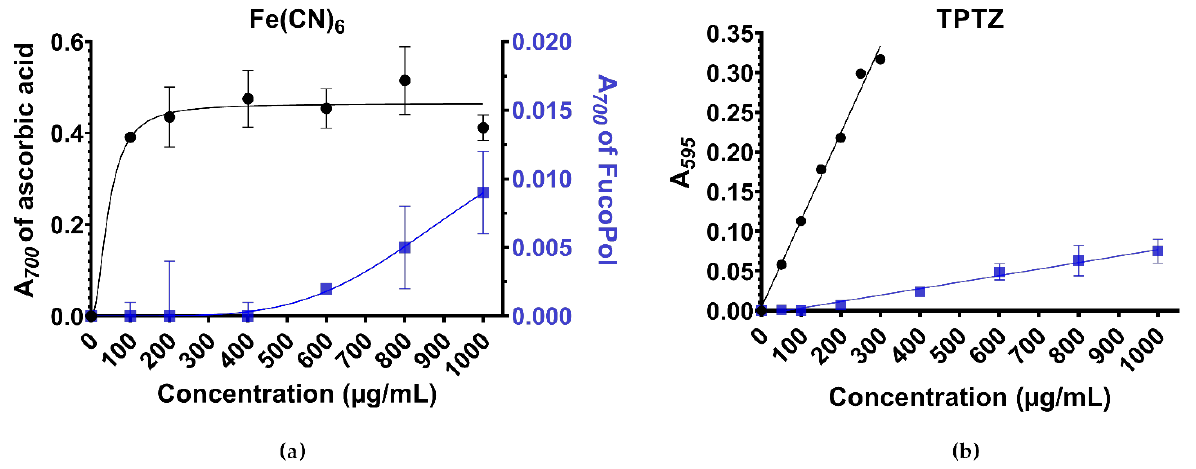
Figure 1. Antioxidant properties of the polysaccharide FucoPol (blue squares), presented as mean absorbance of the final reaction product as a function of concentration. Concentrations represent effective concentration of a molecule in aqueous medium, and do not factor in reactional mixture dilutions. ( a ) FRAP assay using ferricyanide as oxidant species and ascorbic acid (vitamin C) as positive control (black circles). Best-fit curves are shown to demonstrate tendency of change. Best fit for FucoPol was a second-order polynomial, y = 10 − 8 x 2 − 5 × 10 − 6 x (R 2 = 0.993). ( b ) FRAP assay using TPTZ as the oxidant species and Trolox (water-soluble vitamin E analog) as the positive control (black). Best fit for FucoPol was a first-order polynomial, y = 8.19 × 10 − 5 x − 0.004872 (R 2 =